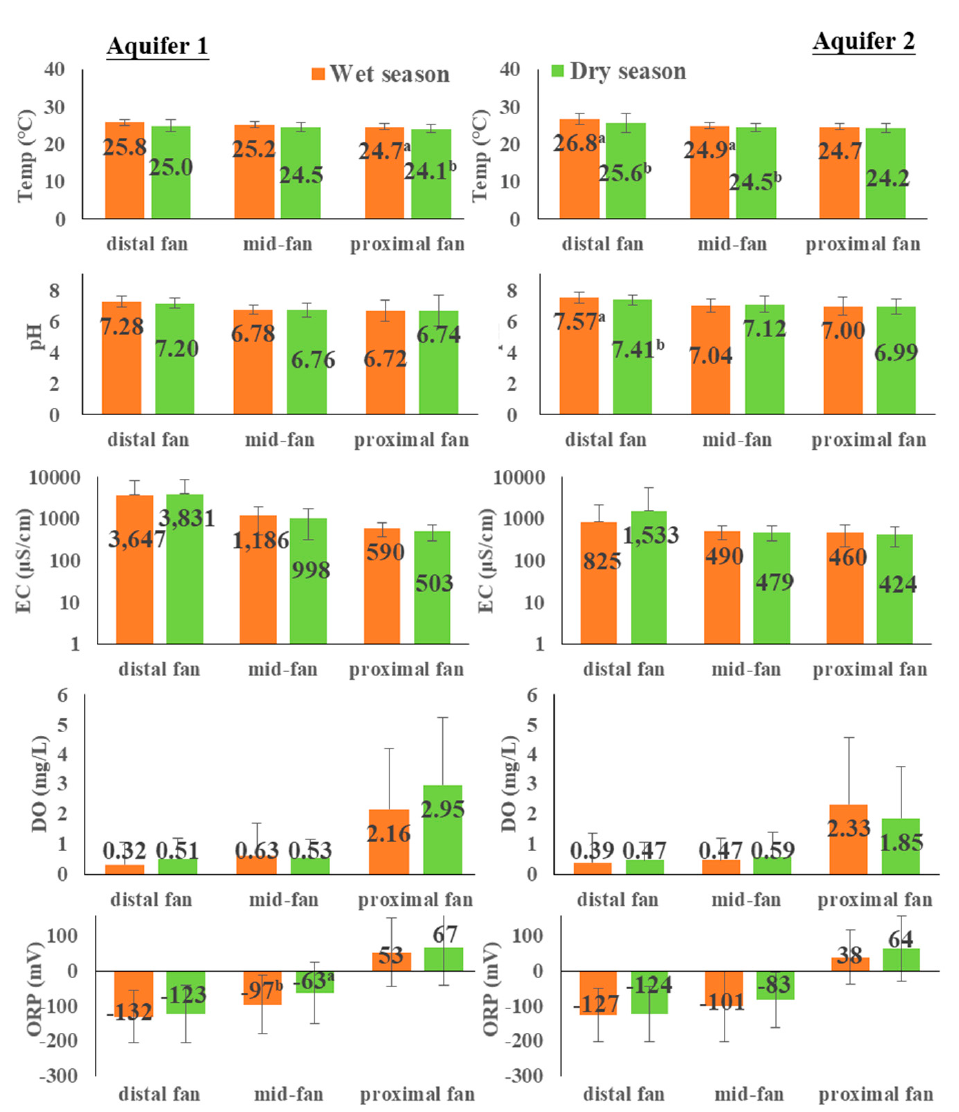
Figure 6. The mean values of the five on-site parameters and the statistical results of the proximal fan, mid-fan, and distal fan areas in both aquifers between the wet and dry seasons. (a superscript character after the mean value means that the water quality parameter has significant